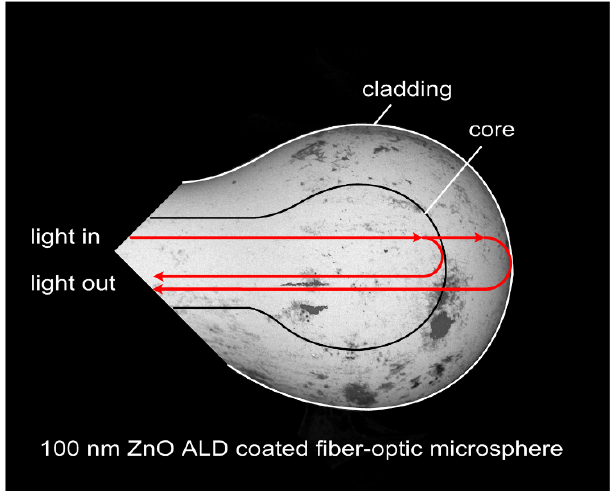
Figure 3. Principle of operation of a microsphere-based fiber-optic sensor.